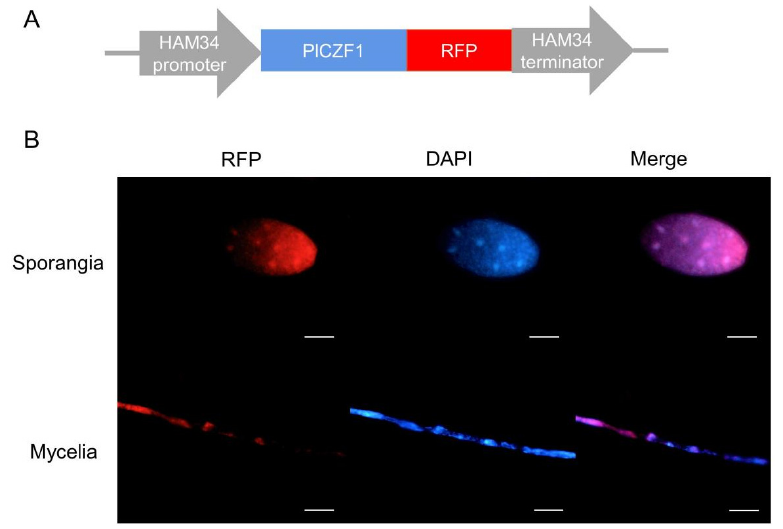
Figure 2. Subcellular localization of PlCZF1. ( A ) The illustration of the construct produced for PlCZF1 localization. ( B ) The hypha and sporangia of the fluorescent transformants of P. litchii were observed under a fluorescence microscope during red fluorescence (RFP) and DAPI (blue) staining. The scale of the sporangium stage is 5 μ m, and the scale of the hyphae stage is 10 μ m.